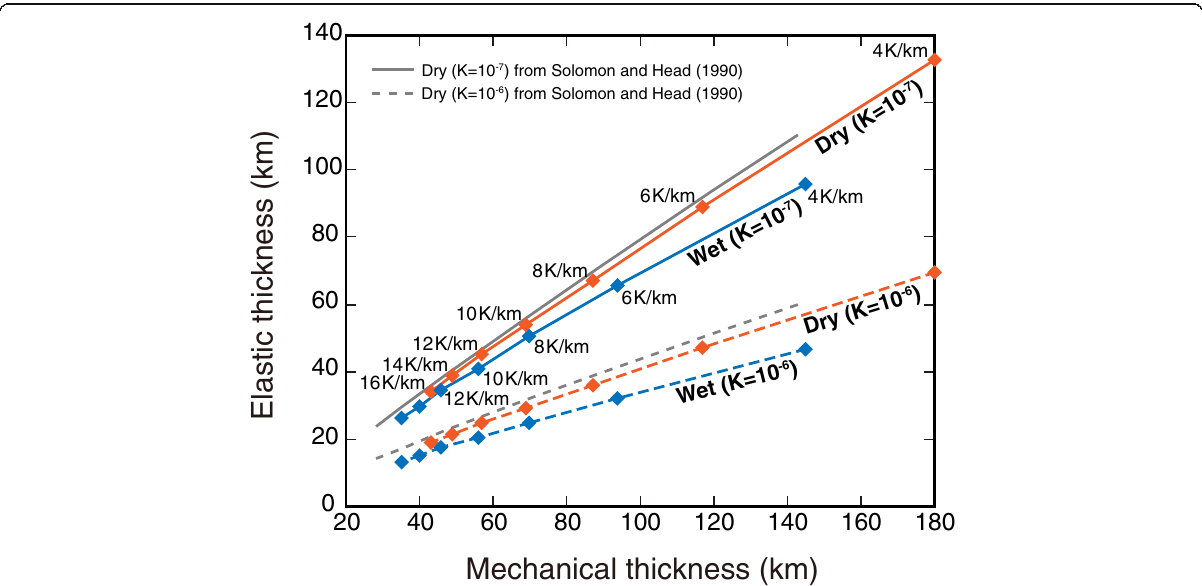
Fig. 5 Relationship between elastic thickness and mechanical thickness. The calculations were made using uniform thermal gradients similar to Solomon and Head (1990). The results for dry mantle rheology agree nearly with their data, but wet rheology gives a markedly thinner elastic and mechanical thicknesses than those for dry rheology at a given thermal gradient. Solid and dashed lines are results using flexural curvature of 10 − 7 and 10 − 6 m − 1 ,